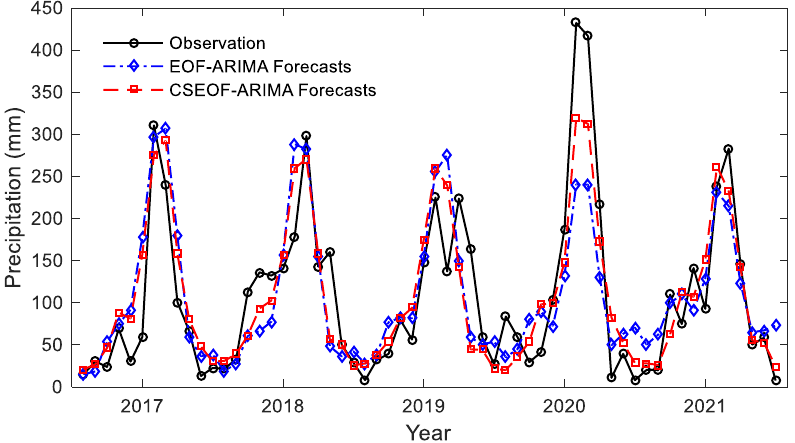
Figure 11. Temporal mean of observation with EOF – ARIMA and CSEOF – ARIMA forecasts.